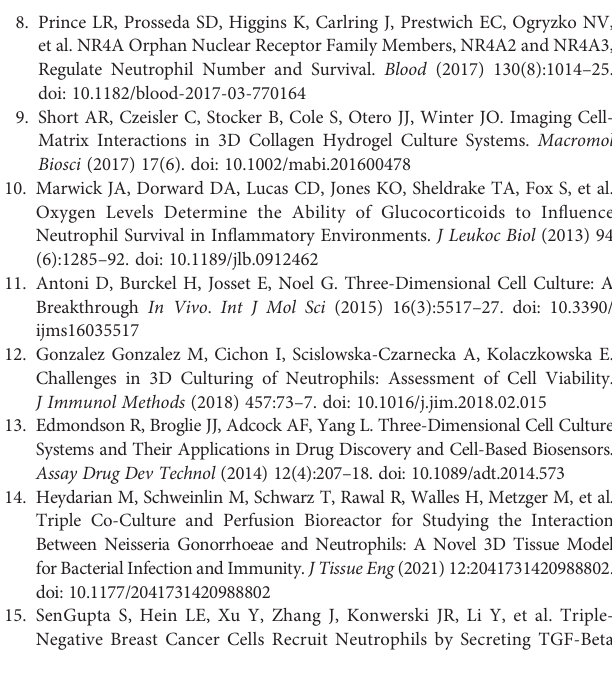
Supplementary Figure 1 | (A) The formation of NETs when stimulated by PMA for 4 h in 2D and 3D culture systems which marked by NE (Alexa Fluor 488 dye, green) and nuclear (DAPI, blue) were observed in mouse peripheral blood Neu under a fl uorescence microscope in vitro . (B) Mouse peripheral blood Neu released NETs marked by LY6G (PE, red) and nuclear (SYTO 13, green) when stimulated by LPS (2.5 m g/mL)/ATP (3 mM), IL-1 b (20 ng/mL) and TNF a (20 ng/ mL) for 4 h in 2D and 3D culture systems under a confocal microscope in vitro . (C) A signi fi cantly different dsDNA release was detected using fl uorescent-based Picogreen assay. Error bars represent mean ± S.D. n = 3, **** p < 0.0001 by Two- way ANOVA. Supplementary Figure 2 | Mouse peripheral blood Neu which were dyed by SYTO13(stainDNAinbothliveanddeadeukaryoticcells)andPI(stainDNAindead eukaryotic cells) during 6 days in 2D and 3D culture systems with or without the inhibition of apoptosis z-vad-fmk. Supplementary Figure 3 | Human peripheral blood Neu which were dyed by SYTO 13 and PI during 6 days in 2D and 3D culture systems with or without the inhibition of apoptosis z-vad-fmk. Supplementary Figure 4 | Immuno fl uorescence analysis using confocal laser microscopy of human peripheral blood Neu co-culture with NCM460 in 2D and 3D systems. (A) The location (white arrow) of cells in XZ and YZ view of the cell model were observed. Z-stacks were acquired using confocal fl uorescence microscopy and were reconstructed using Olympus FV31S. (B) Three-dimensional reconstruction of C2C12 and Neu co-culture, and the cross-section of monolayer cells (white lines). Supplementary Video 1 | Three-dimensional image of human peripheral blood Neu co-culture with NCM460 in 2D and 3D culture systems. Neu produced NETs under LPS (2.5 m g/mL)/ATP (3 mM) for 4 h stimulation. Supplementary Video 2 | Three-dimensional image of human peripheral blood Neu co-culture with NCM460 in 2D and 3D culture systems and the location of cells in Z-stacks. Supplementary Video 3 | Three-dimensional image of Neu and C2C12 co- culture in 2D and 3D culture systems. Neu produced NETs (white arrows) under 20 m M PMA for 4 h stimulation, and the depth of cells spanned during culture (white